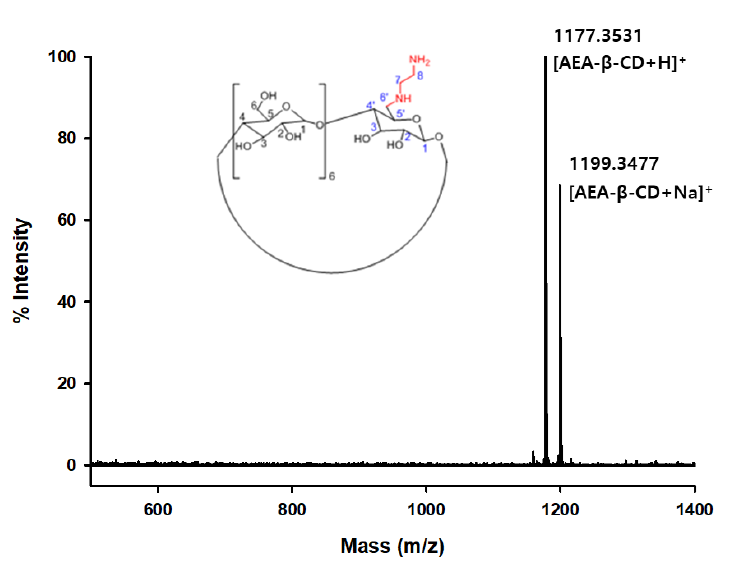
Figure 1. MALDI-TOF-MS of AEA – β – CD.